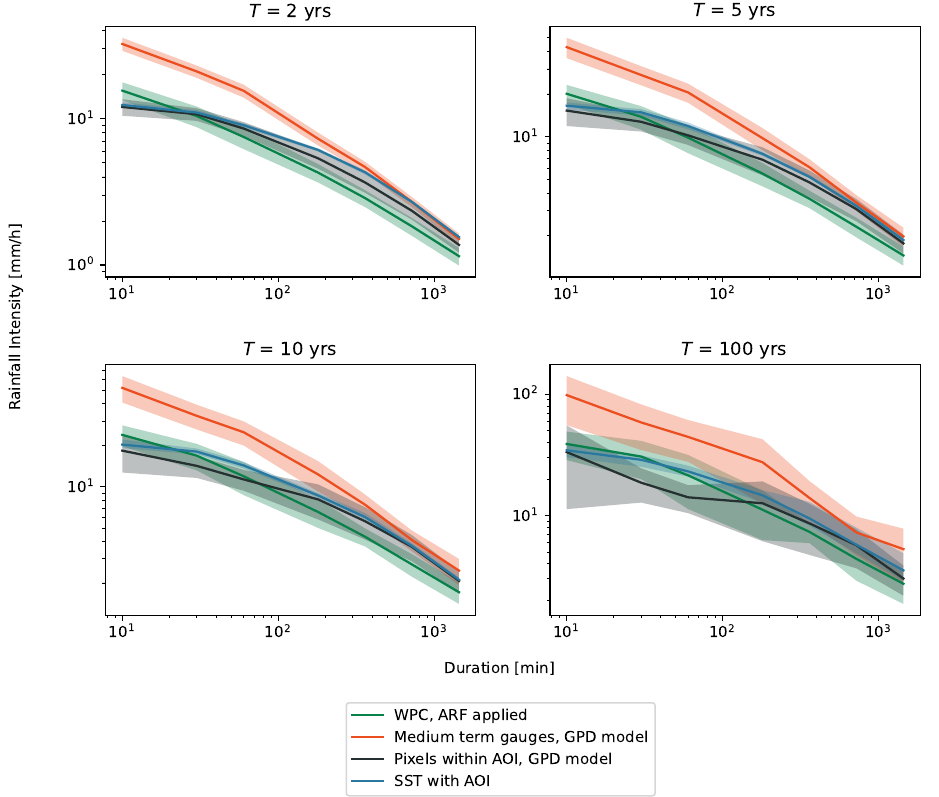
Figure 8. IDF curves (10 min to 1440 min) for the regional model with ARFs applied (green, WPC); collection of medium-term gauges, derived from GPD fit (orange, Gauge); radar pixels within the AOI, derived from GPD fit (black, Radar) and the SST framework for AOI (blue, SST). Shaded area depicts 95% confidence interval and total ensemble spread for SST values. Each curve is representing a return level of: 2, 5, 10 and 100